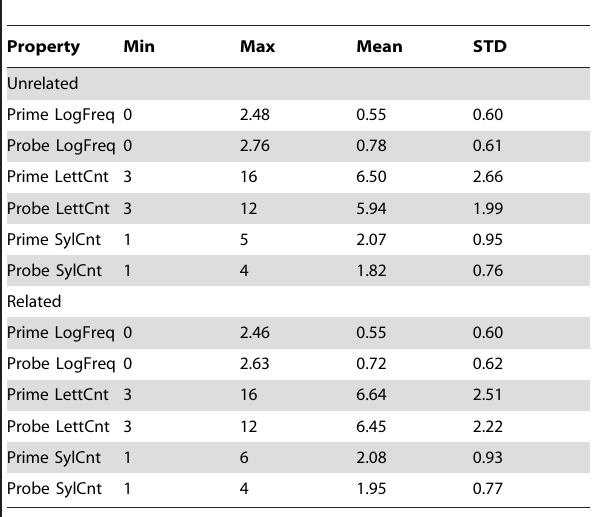
Table 1. Stimulus matching properties for the related